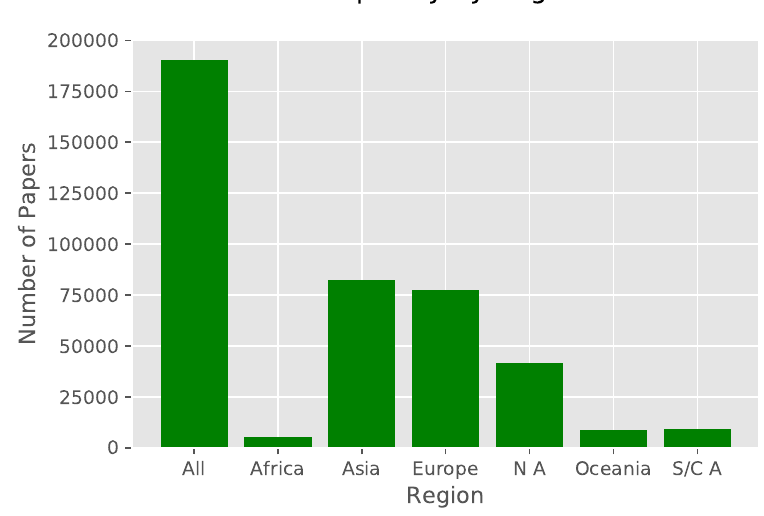
Figure 16. This chart shows the number of papers published in MDPI journals from 1996 through 2018 with at least one author from a country in a given region. Note that the sum of each region exceeds the total number of papers; this result is a consequence of international collaborations that transcend regional